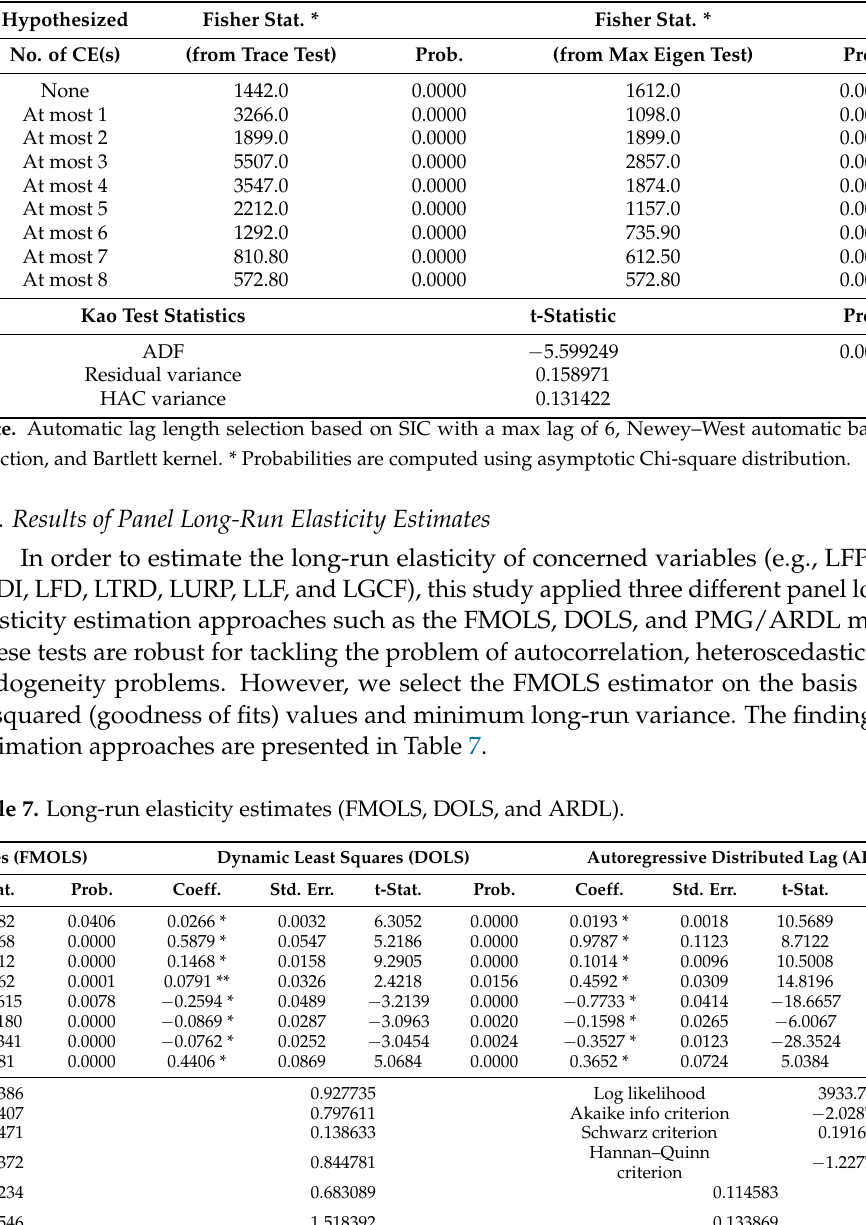
Table 6. Results of Johansen Fisher and Kao cointegration test.